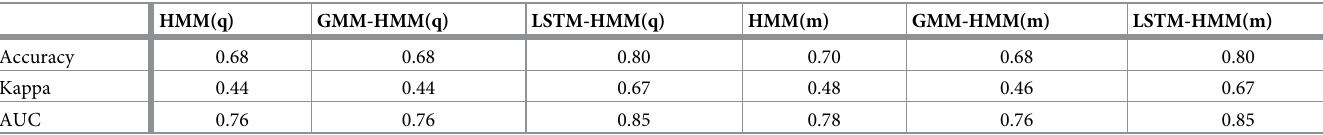
Table 14. Accuracy, kappa and AUC for HMM, GMM-HMM and LSTM-HMM with monthly or quarterly input and 10-year time window.